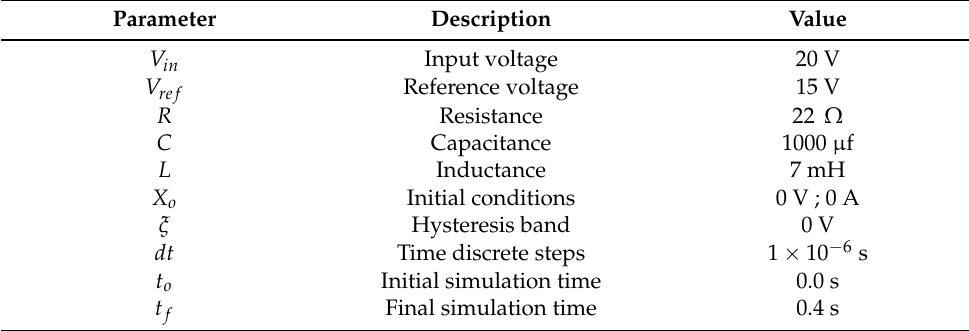
Table 1. Buck converter system